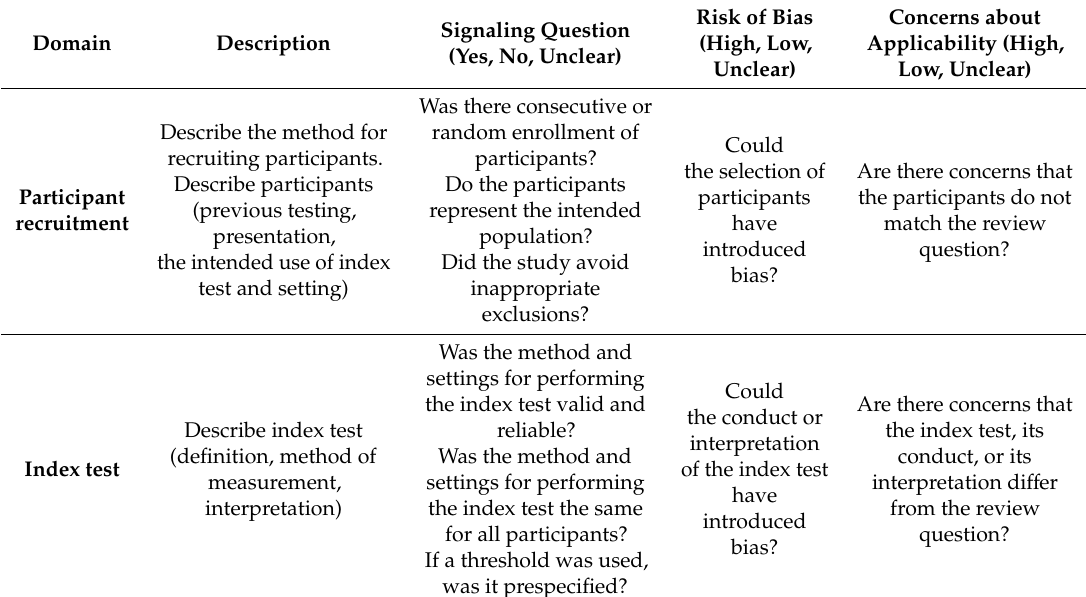
Table A1. Quality Assessment of Prognostic Accuracy Studies (QUAPAS)